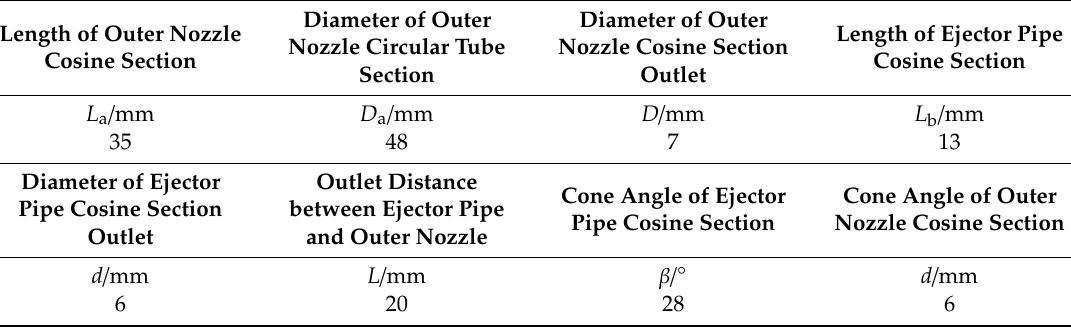
Table 1. Structural parameters of the double cosine self-aspirated